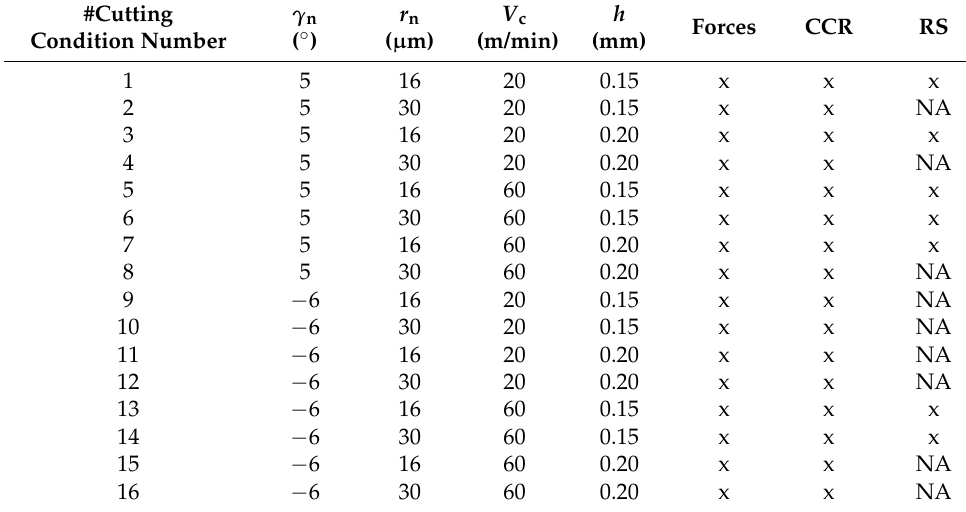
Table 3. Design of experiments matrix and available results (x—data is available; NA—not available).